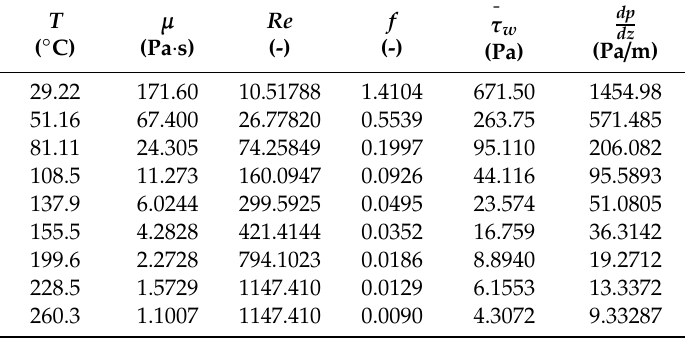
Table 7. Values of the fluid dynamic parameters obtained in the simulations with β = 0.02 and N =